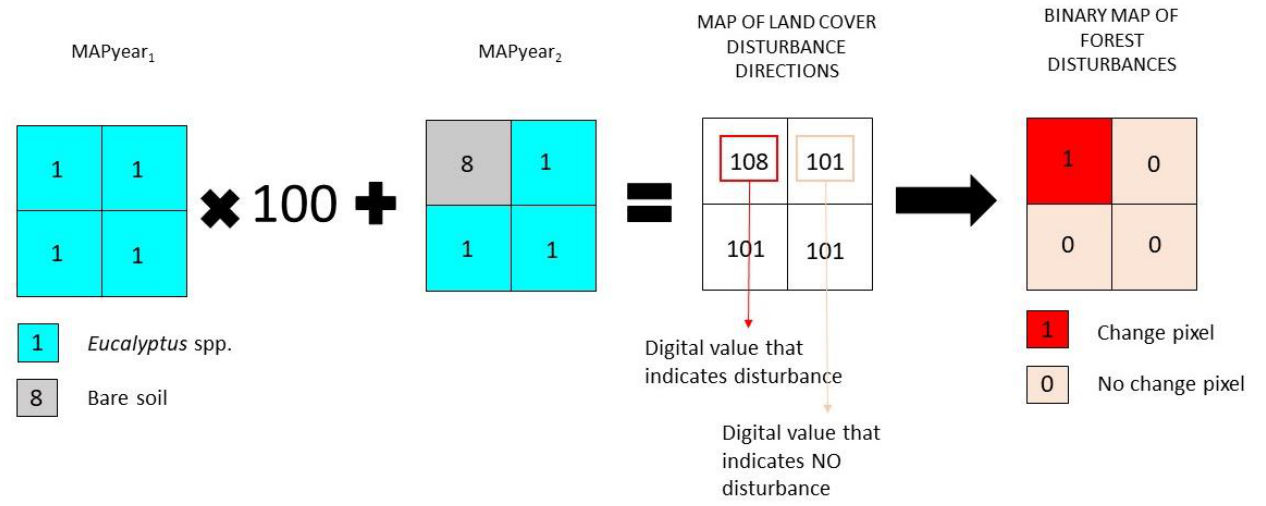
Figure 3. Diagram of the procedure followed to perform the inter-annual comparisons between paired years in order to obtain the land cover changes. MAPyear 1 : land cover map of the earlier year of the bi-annual analyzed land. MAPyear 2 : land cover map of the later year of the bi-annual analyzed land.